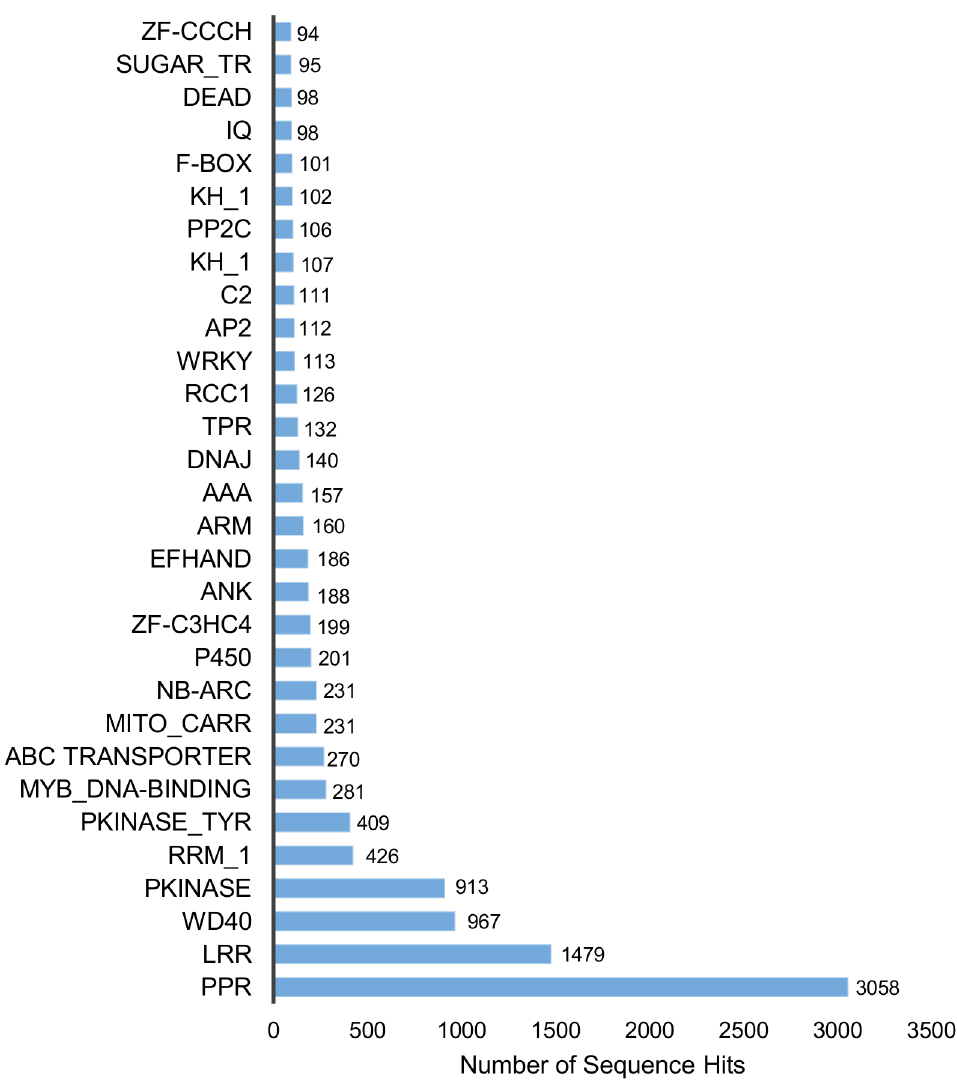
Figure 6. Distribution of the top 30 Pfam domains identified in translated H.brasiliensis transcripts.